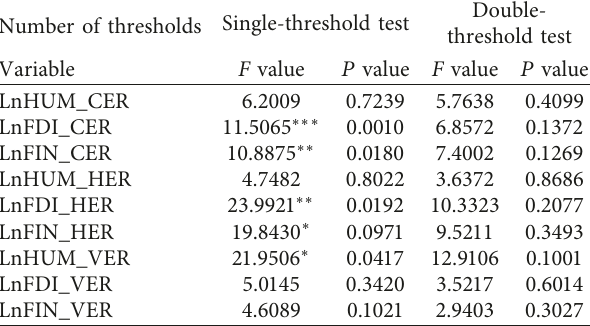
Table 4: Test of the threshold